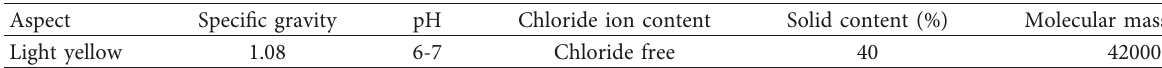
Table 2: Properties of SP used in this research.